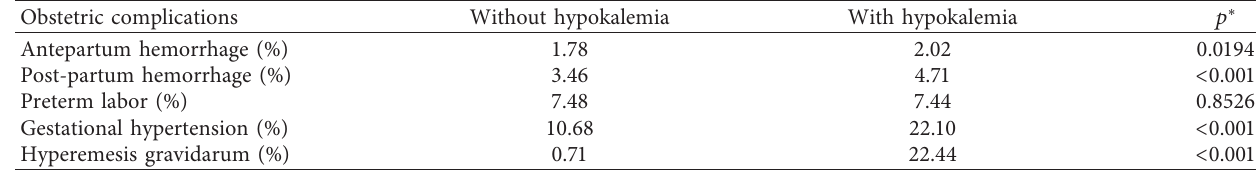
Table 4: Obstetric complications of pregnancy-related admissions for women with and without hypokalemia. Obstetric